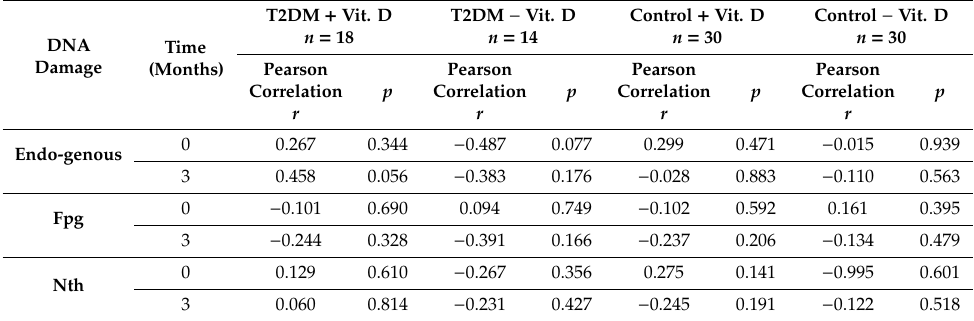
Table 4. The correlation between Vitamin D and endogenous and oxidative DNA damage in patients with T2DM (T2DM + Vit. D, n = 18; T2DM – Vit. D, n = 14) and patients without T2DM (Control + Vit. D, n = 30; Control – Vit. D, n = 30) at baseline (0) and after three months of vitamin D supplementation (3). The analysis was performed by Pearson’s correlation